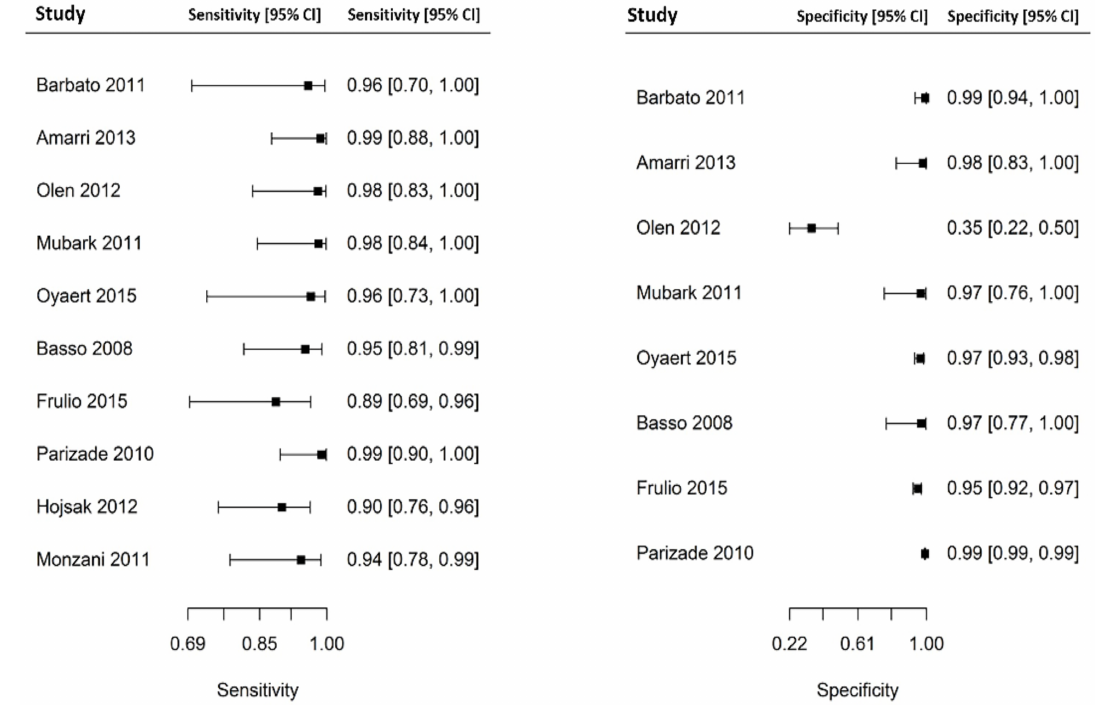
Figure 2. Forest plot for sensitivity and specificity of immunoglobulin G anti-deamidated gliadin peptide antibody (DGP IgG) determination.